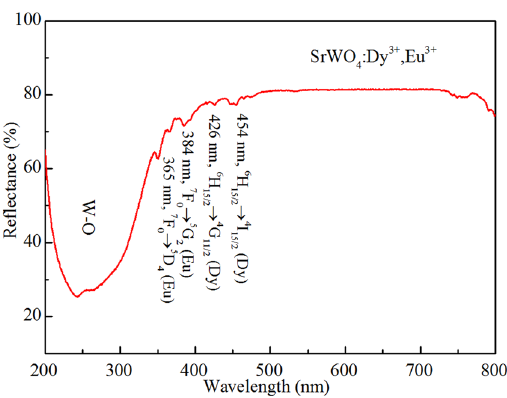
Figure 4. The ultraviolet-visible diffuse reflectance spectrum of the SrWO 4 : 0.4 mol% Eu 3 + , 4 mol% Dy 3 + phosphor at room